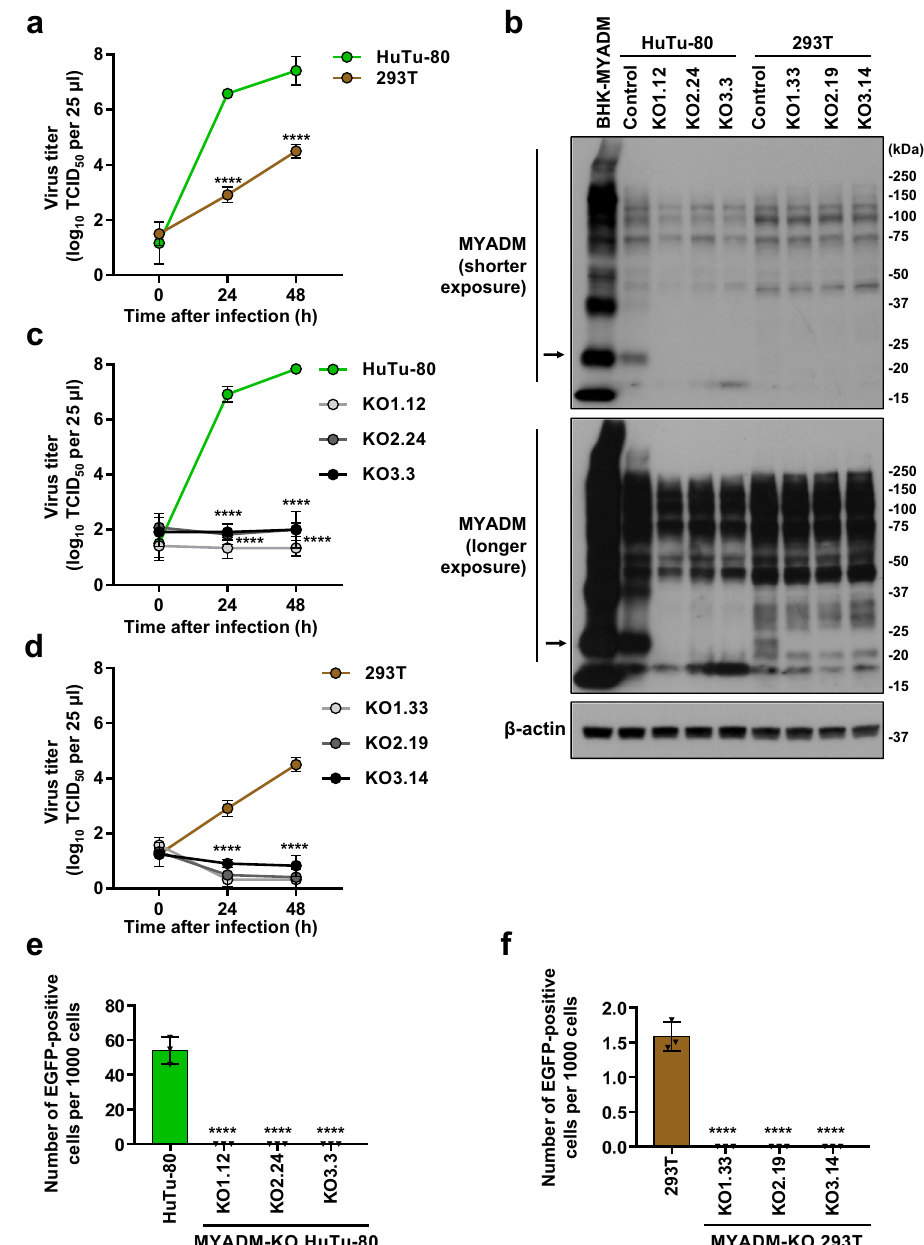
Fig. 3 | MYADM-KO abrogates PeV-A3 infection to susceptible cells. a, c, d The indicated cells were infected with PeV-A3 (A308/99) at an MOI of 0.01, and the amount of virus (virus titer) in the culture supernatant was measured at 0, 24 and 48h after infection. The virus titers in the culture supernatant of HuTu-80 (green circle), 293T (brown circle), HuTu-80-MYADM-KO1.12 (light gray circle), KO2.24 (dark gray circle), KO3.3 (black circle), 293T-MYADM-KO1.33 (light gray circle), KO2.19 (dark gray circle), KO3.14 (black circle) cells are shown as the mean ±s.d. from triplicate experiments. Data from one experiment representative of two independentexperiments ( N =2)are shown. P valueswerecalculated bya two-way ANOVA with Sidak ’ s ( a ) or Tukey ’ s ( c, d ) multiple comparisons test. **** P <0.0001. b Cell lysates were prepared from the indicated cells, and the amount of MYADM